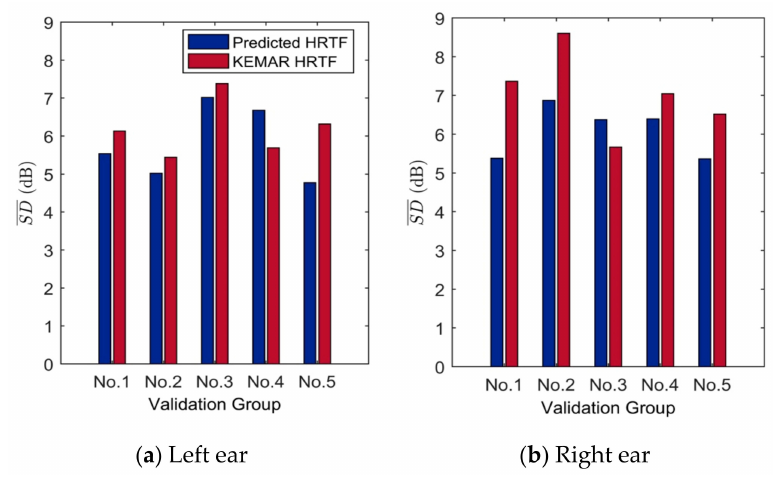
Figure 8. Mean spectral distortion of the validation group at 25 elevations in the median